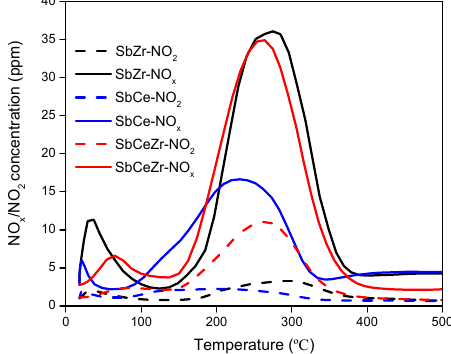
Figure 6. NO-TPD profiles of the catalysts.